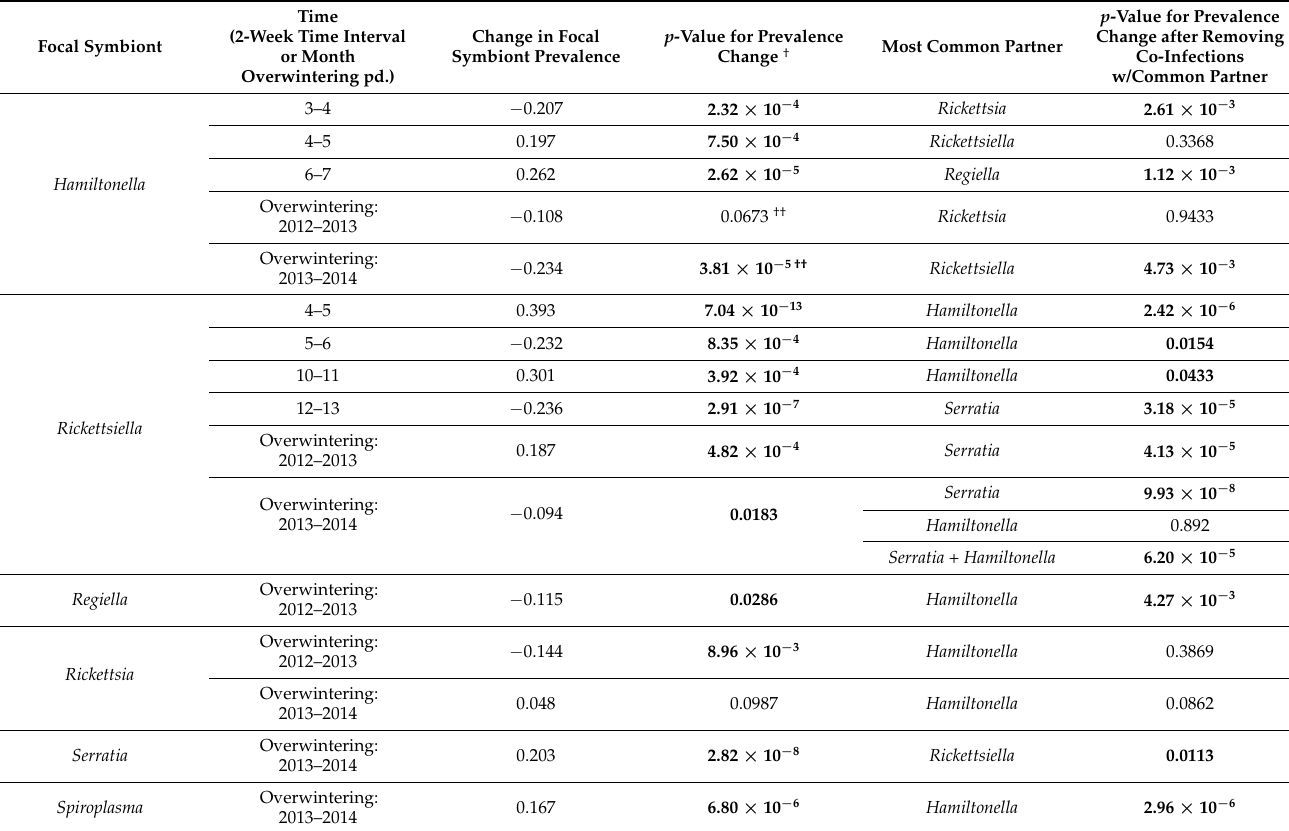
p -Value for Prevalence Change after